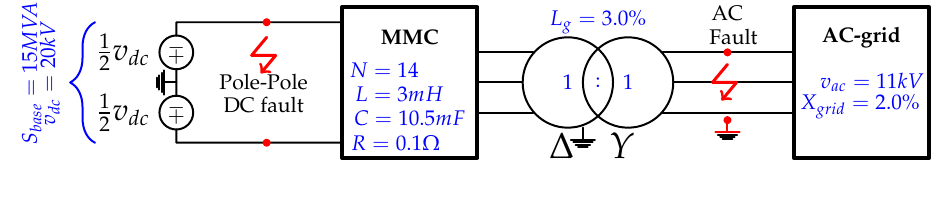
Figure 7. PSCAD model